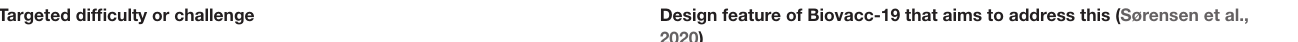
TABLE 1 | Design features of Biovacc-19 aimed to minimize and prevent known risks. Targeted difficulty or